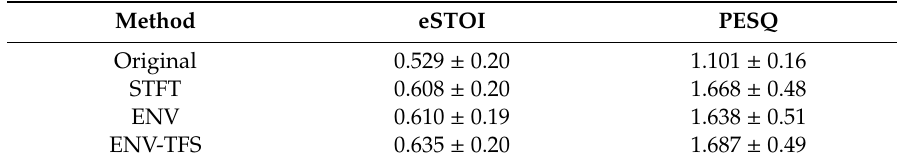
Table 2. Objective speech intelligibility (eSTOI) and quality (PESQ) results for normal-hearing listeners between the ENV, the ENV-TFS and the STFT-based speech enhancement systems.